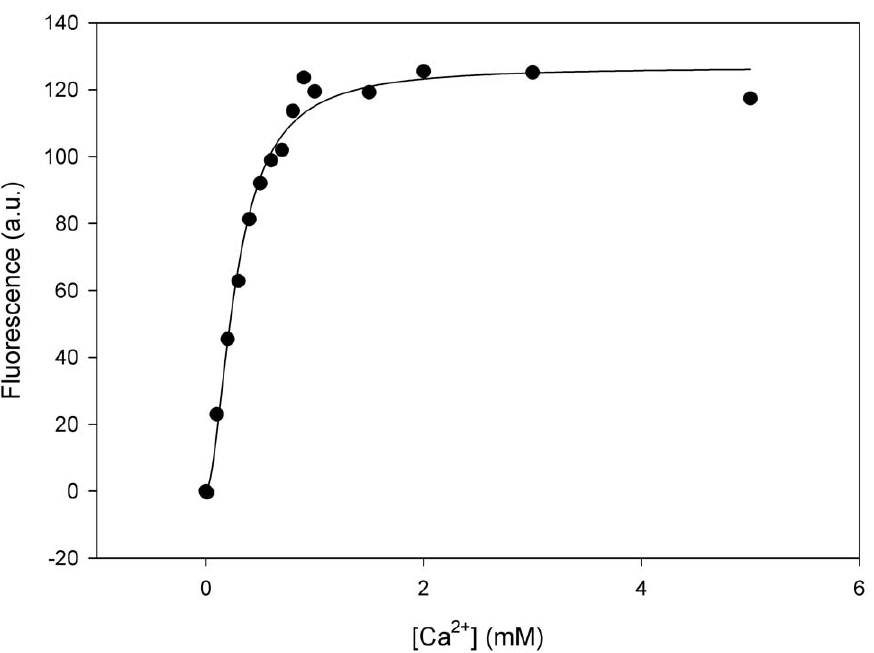
Figure 3. Representative fluorescence data of Ca 2 + -binding by FCSQ. Fitting of this data yields a K d value of 102 m M and a Hill coefficient of 1.8.